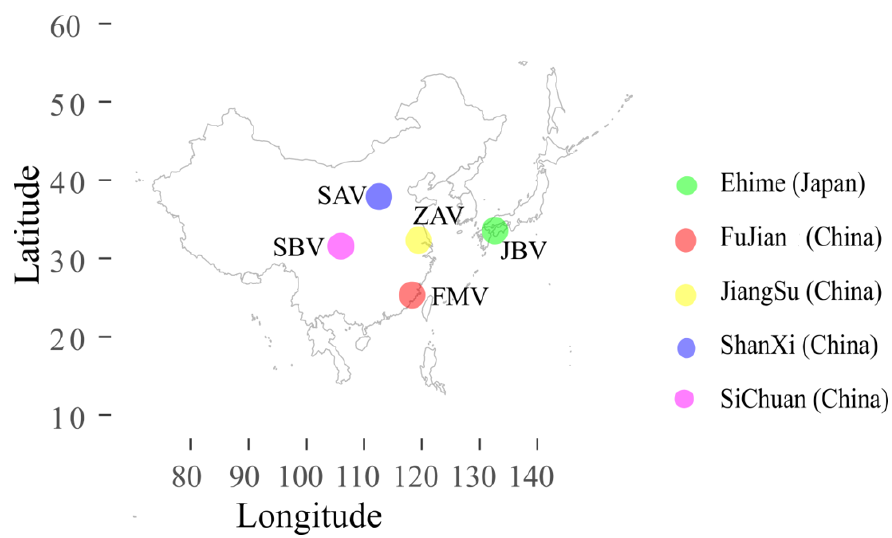
Figure 6. Origin of vinegar production in this